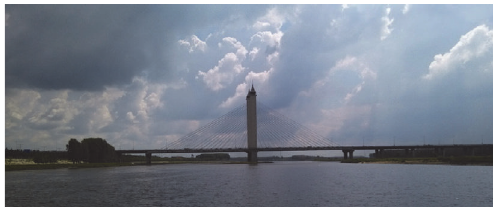
Figure 20: Overview of the Songyuan